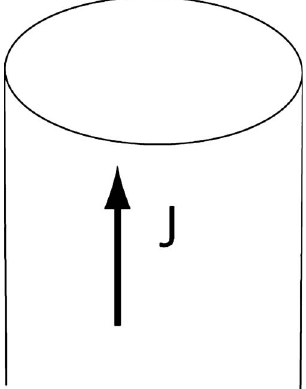
FIG. 1. Question 17 from the CUE (cid:4) 5 (cid:5) : Consider an infinite nonmagnetizeable cylinder with a uniform volume current density J . Where is the B -field maximum? Explain how to determine this. The detailed grading rubric for this question assigned two points for correctness and five points for reasoning.